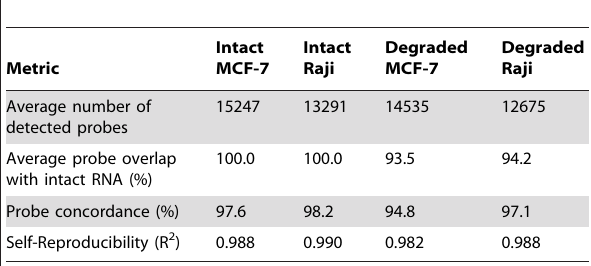
Table 2. WG-DASL Assay Performance with Intact and Artificially Degraded RNA